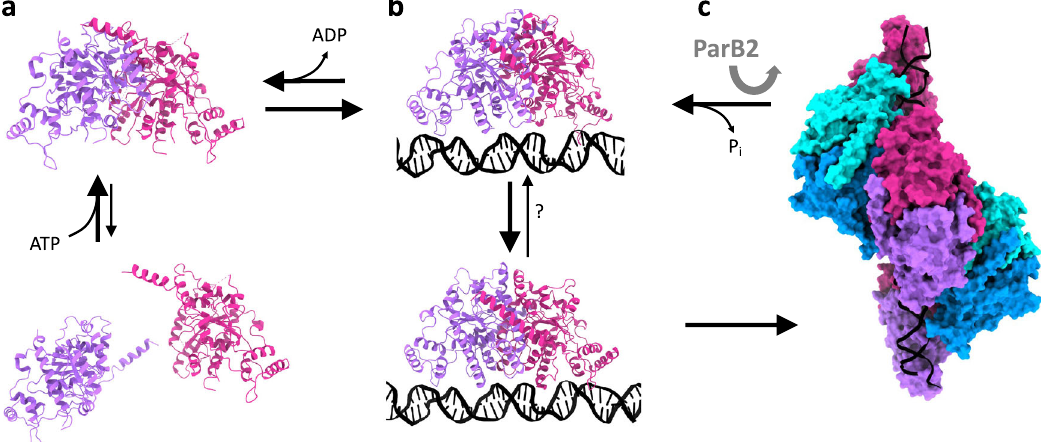
Fig. 6 Proposed mechanism for ParA ’ s cooperative binding to DNA, regulated by ParB. a In isolation, ParA is in equilibrium between monomer and dimer, with the dimer stabilized by the recruitment of nucleotide. b In the presence of DNA, the dimer undergoes a dramatic architecture change, exposing its oligomerization interface. c This leads to the formation of a higher-order assembly, in the form of a short fi lament segment. The presence of ParB-bound cargo stimulates ParA ’ s ATPase activity, which leads to its return to the DNA-free conformation of the dimer. This in turn leads to the dissociation of ParA from the DNA, and the release of